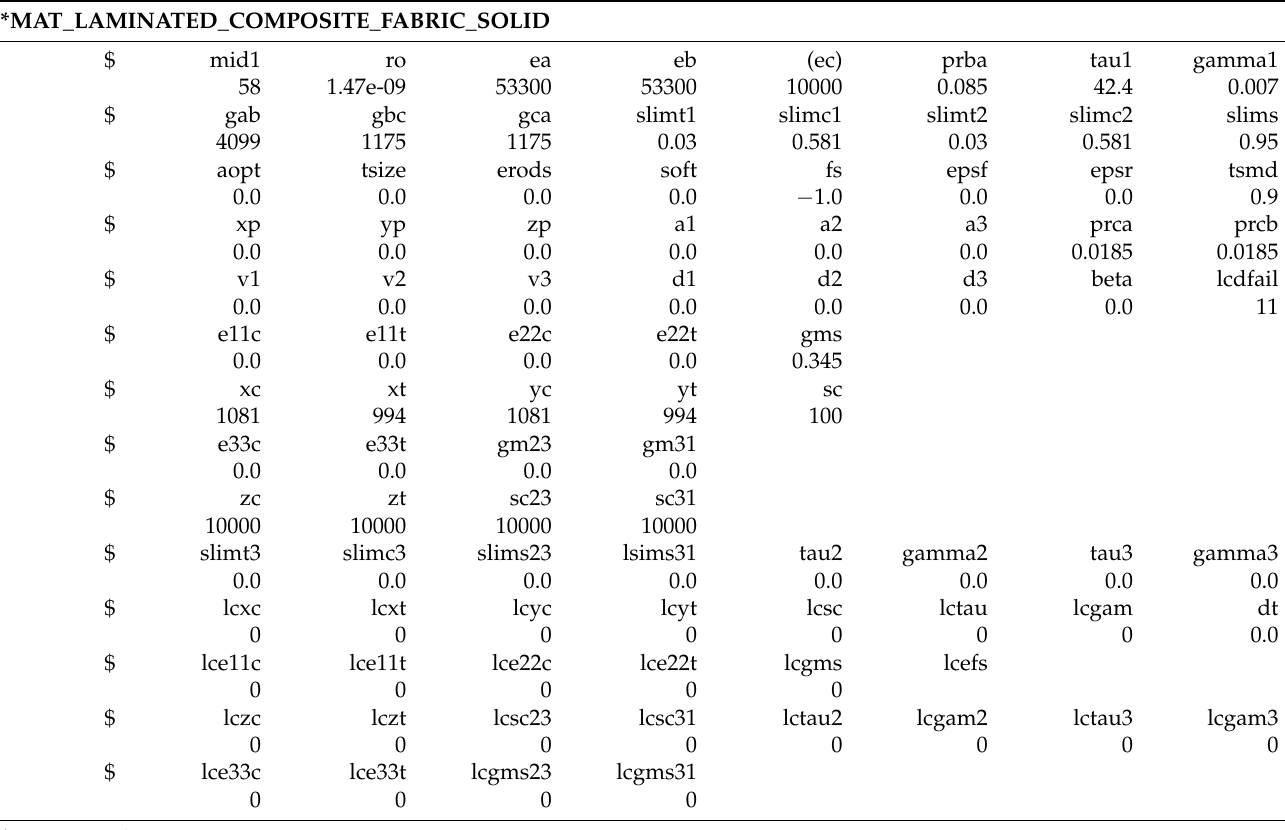
Table A2. Used LS-DYNA material card *MAT_058 in unit system